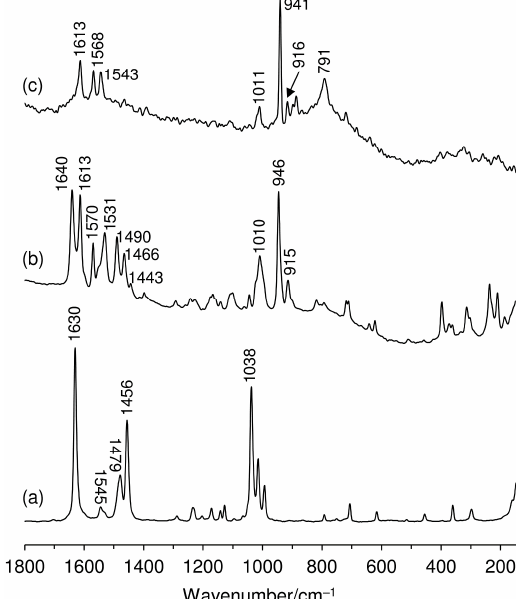
Figure 5. Raman spectra in the region 150–1800 cm − 1 of ( a ) Hpytz, ( b ) compound 1 , and ( c ) hybrid 2